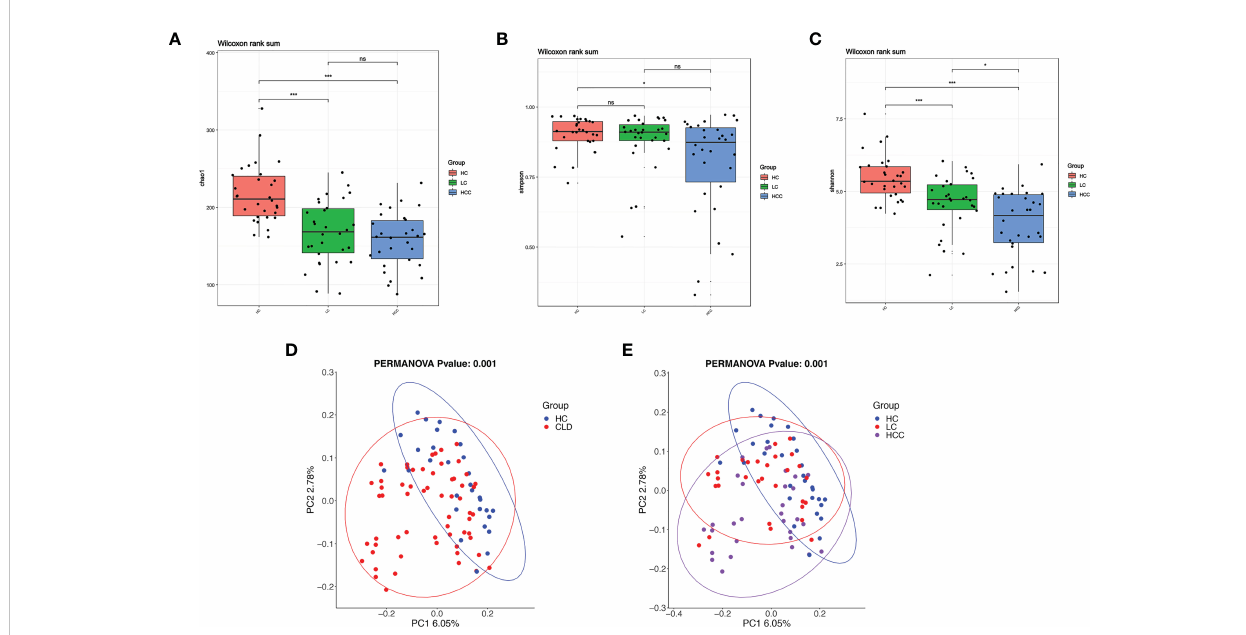
FIGURE 4 With the development of disease, the diversity of fecal microbiome gradually decreases. (A – C) Alpha-diversity based on observed number of species in HC controls, HBV-LC, and HBV-HCC fecal samples. Box plots indicate the median (middle line) and the 25 th and 75th percentiles (box). The fi gure shows the distribution of the diversity index in each group and indicates whether there is a signi fi cant difference in the diversity index between the three groups. (D, E) Beta-diversity using constraint analysis of principal components analysis (PCoA). Each sample is represented by a dot. Ellipses are added with function ‘ stat_ellipse ’ with a con fi dence level of 0.95. *P < 0.05, ****P < 0.0001; and ns indicates no signi fi cant difference. (A – E) sample size is healthy control, n = 30, HBV-LC, n = 30, HBV-HCC, n = 30 as biologically independent